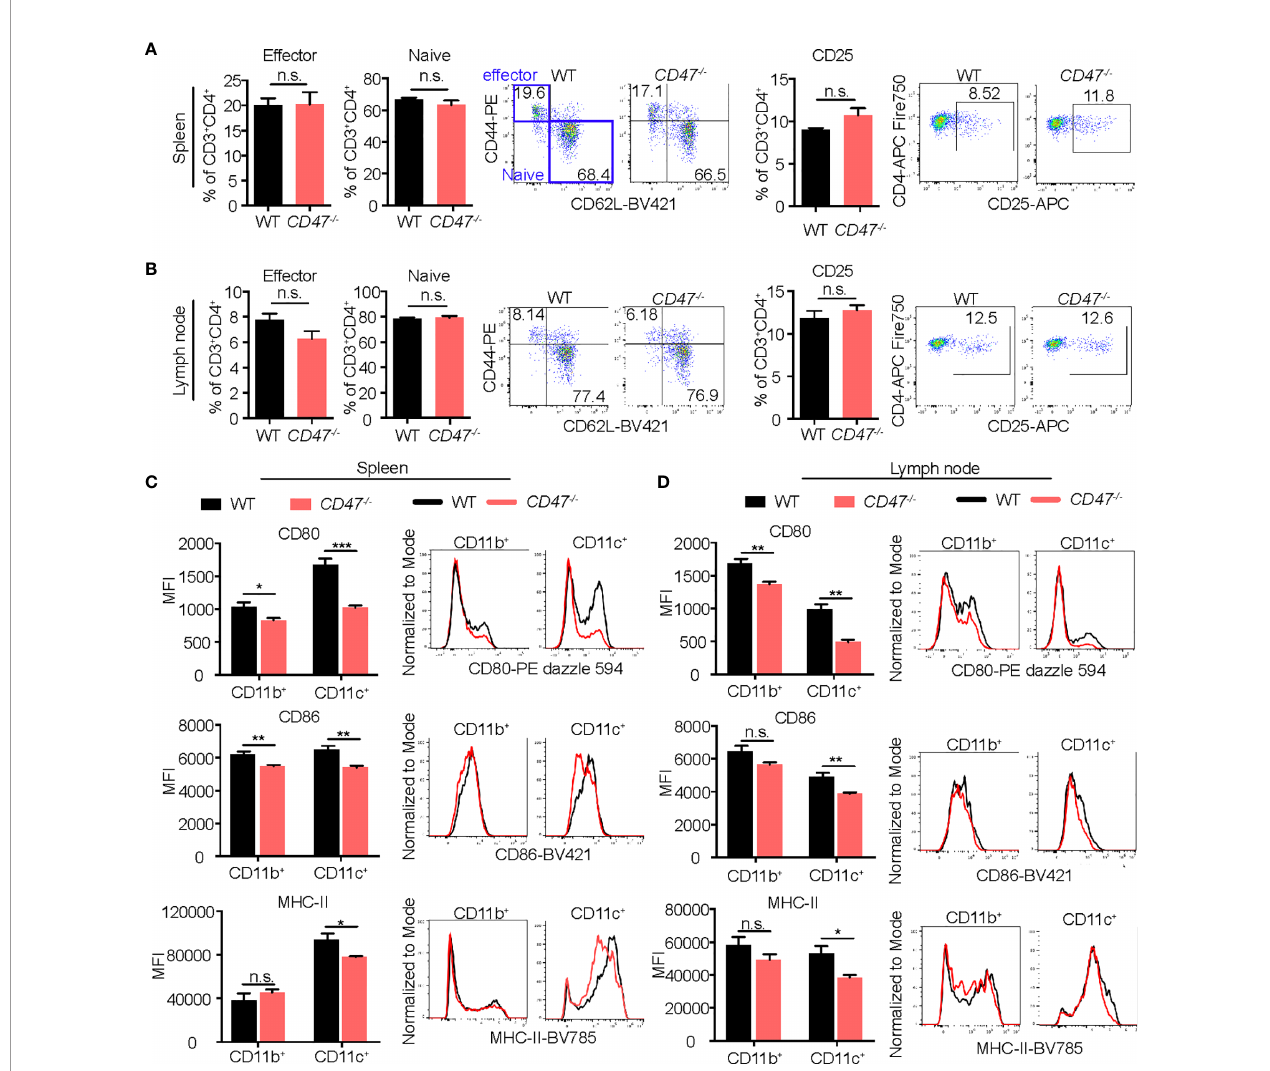
FIGURE 6 | Activation of macrophages and DCs is suppressed in EAU in CD47 de fi cient mice. WT and CD47 -/- mice were immunized and SP and LN cells were collected 14 days post immunization. Expression of cell activation makers on CD4 + T cells, and CD11b + (DCs/macrophages) cells and CD11c + (DCs) cells were evaluated by fl ow cytometry. (A, B) For CD4 + T cells, live cells excluding B cell (CD19), NK cells (NK1.1), and granulocytes (Ly6G) were gated on CD45 + CD3 + CD4 + cells. Frequency of CD62 - CD44 + (effector) cells, CD62 + CD44 - (naïve) cells, and CD25 + activated CD4 + T cells were examined in spleens (A) and lymph nodes (B) . (C, D) For DCs/macrophages, live cells excluding T cells (CD3), B cells (CD19), NK cells (NK1.1), and granulocytes (Ly6G) were gated on CD45 + CD11b + and CD45 + CD11c + cells. Expression of activation markers CD80, CD86, and MHC-II was examined in spleens (C) and lymph nodes (D) . Data were analyzed by Student ’ s t test and expressed as mean ± SEM. *P<0.05; **P<0.01; ***P<0.001. n.s., not signi fi cant. n=4 mice per